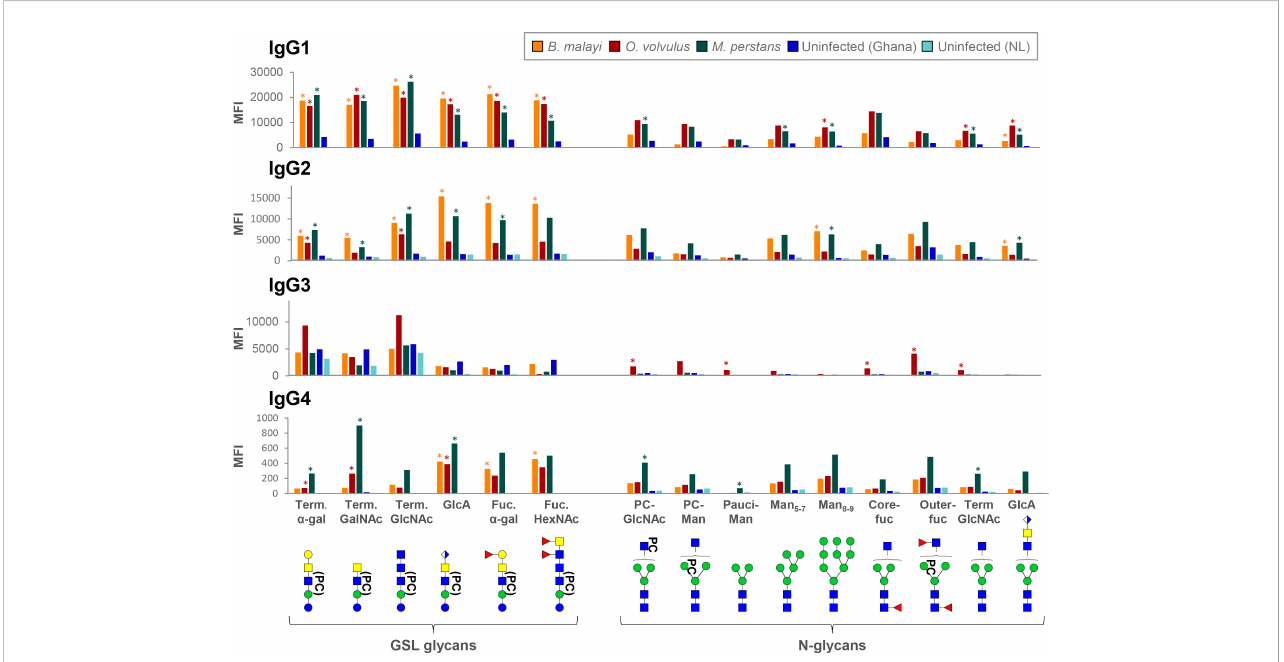
FIGURE 7 Binding of IgG subclasses from B. malayi , O. volvulus and M. perstans infection and control plasmas to B. malayi N-linked and GSL glycan motifs. IgG subclass binding to speci fi c glycan motifs was calculated for each individual by averaging MFIs of fractions belonging to the same category based on their glycan content. Fraction groups are shown on the X-axis and named after the corresponding glycan motif present in the fractions: PC-GlcNAc = PC-substituted GlcNAc, PC-Man = PC-substituted mannose, Pauci-Man = Pauci-mannosidic N-glycans, Man x-y = High-mannosidic N-glycans carrying 5 to 7 or 8 to 9 mannose residues, Core-fuc = a 1-6 core fucosylated N-glycans, Out-fuc = a 1-3 fucose attached to terminal GlcNAc, Term. GlcNAc = Terminal N-acetylglucosamine, GlcA = terminal GlcA, Term. a -Gal = terminal a 1-4 Gal, Term. GalNAc = Terminal N-acetylgalactosamine, Fuc. a -Gal = Fucosylated (terminal) a -1-4 Gal, Fuc-HexNAc = Fucosylated HexNAc(s). A representative glycan structure for each category is shown below the X-axis using the CFG nomenclature (see symbol key inset in Figure 3). Category MFIs thus obtained were averaged for individuals from the same infection or control group: B. malayi - (n = 5) infected individuals (before DEC treatment), O. volvulus- (n = 6) infected individuals, M. perstans- (n = 6) infected individuals, uninfected (uninf.) Africans (Ghana, n = 6) and uninfected Europeans (The Netherlands, NL, n = 5). Signi fi cant differences between groups were assessed using Bayesian statistics. MFIs signi fi cantly higher for infection plasma IgG than for both uninfected groups are indicated with asterisks. Obtained p -values can be found in Table